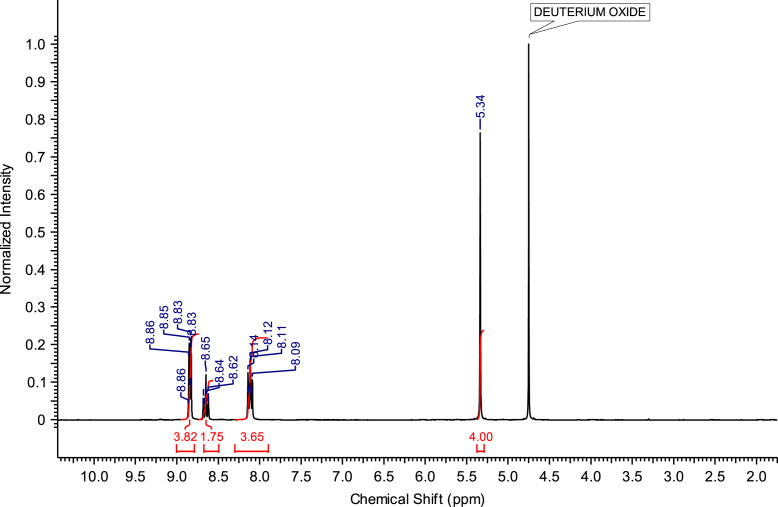
1H NMR spectra of C2(Pyr)2Br2.